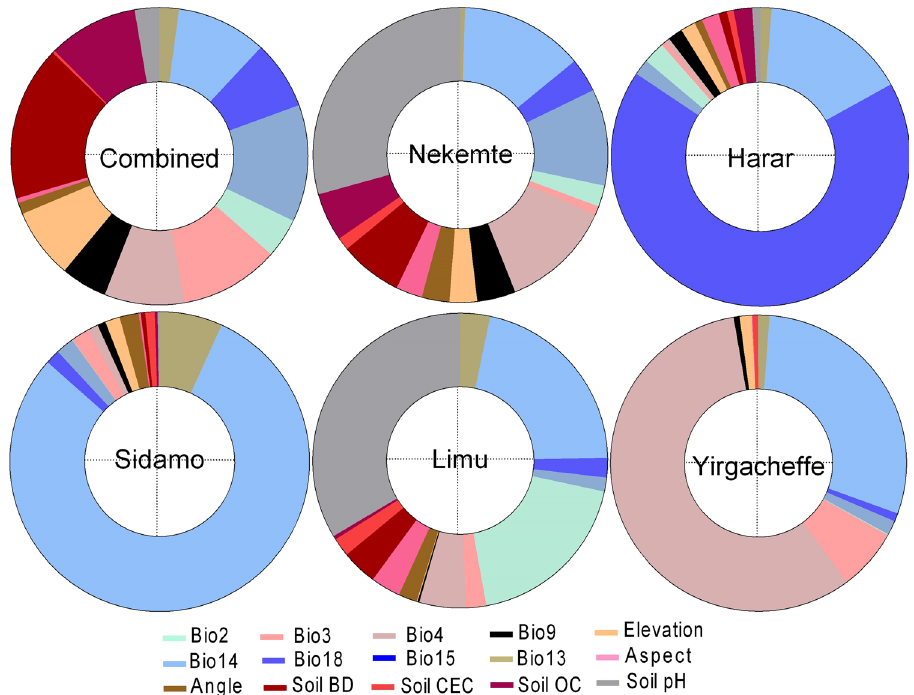
Figure 2. The importance of a variable in explaining coffee suitability for all coffee and five specialty coffees in Ethiopia. Data is obtained from averages of the three individual models. Note the ‘Bio’ variable notations are following the notations used in the WorldClim database, our original database for bioclimatic variables. See SI3 Table for full variable names.